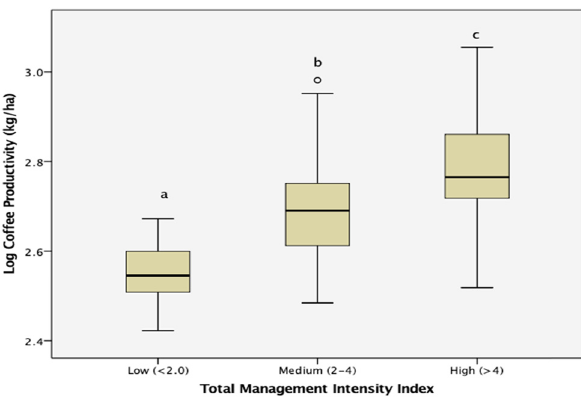
Figure 4: The e ff ect of total management intensity index on log co ff ee productivity; general linear model ( P < 0.000 ) ; means fol - lowed by the same letter did not di ff er ( LSD P < 0.05 ) .